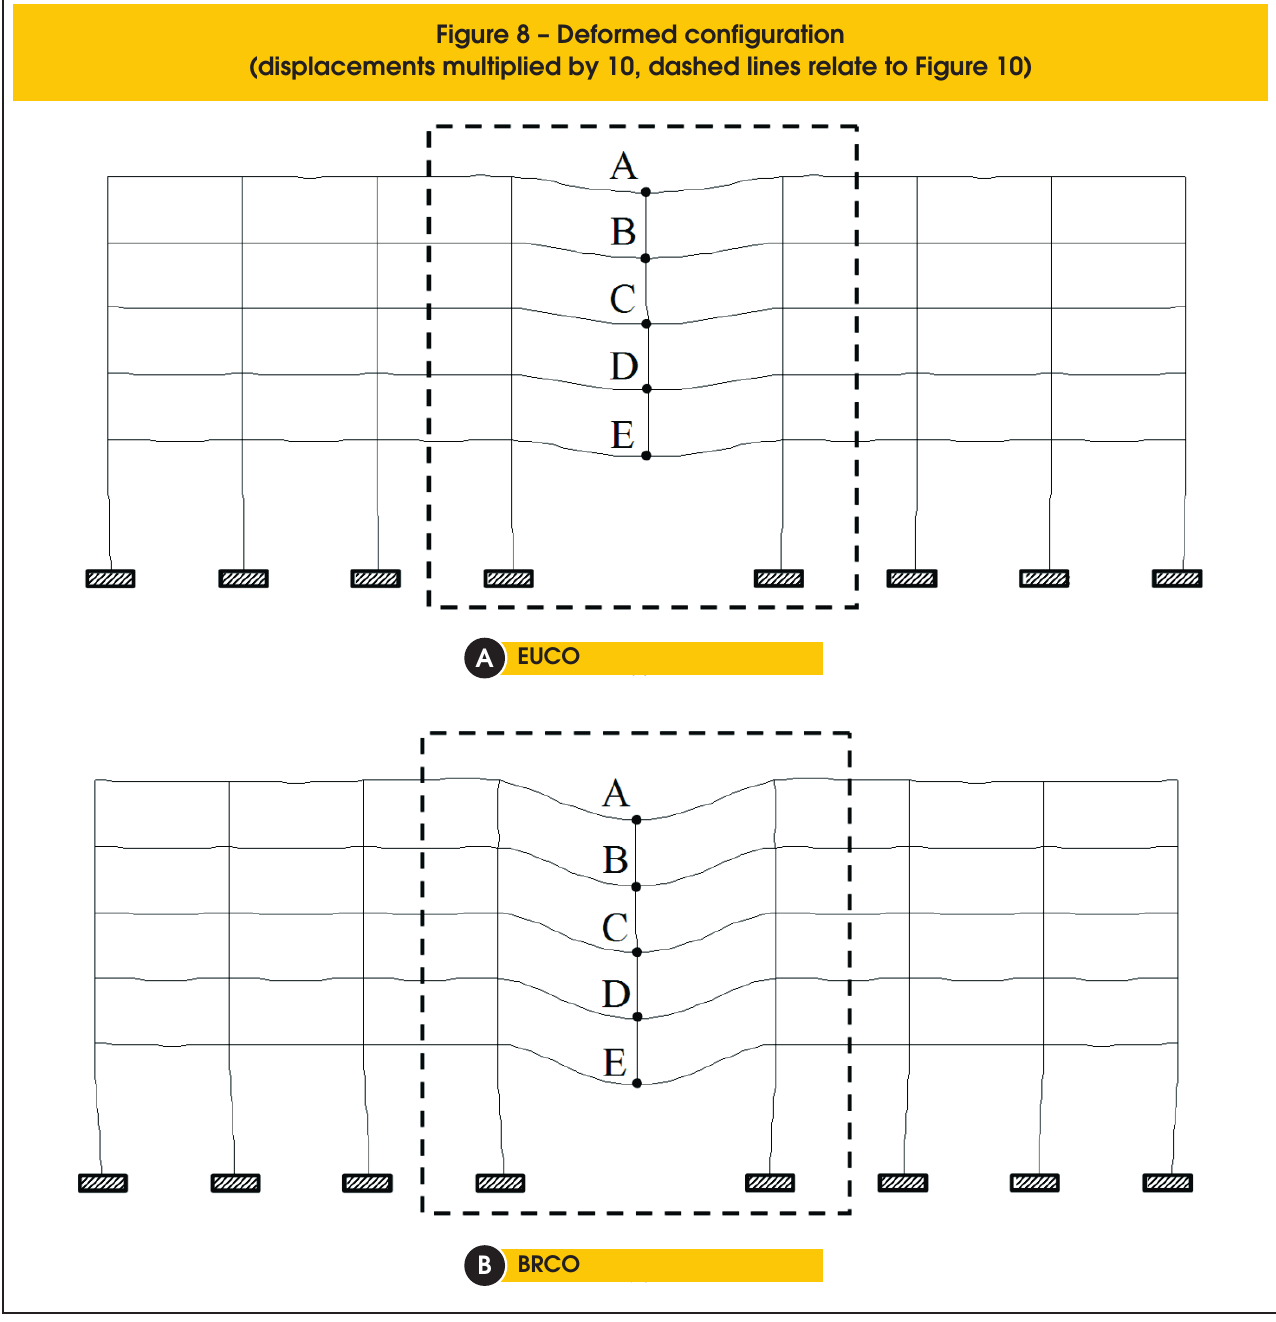
(displacements multiplied by 10, dashed lines relate to Figure